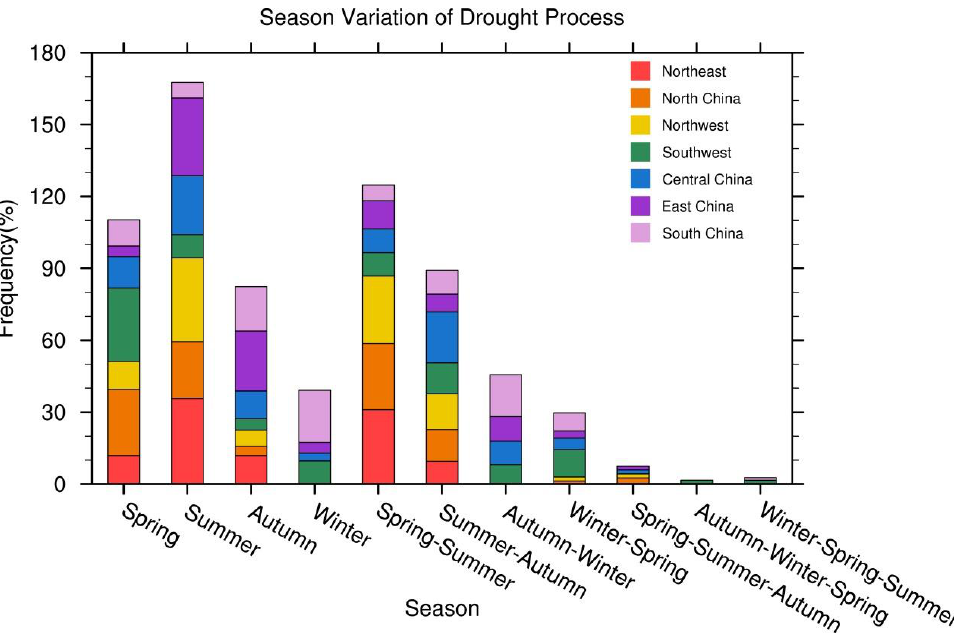
Figure 6. Seasonal distribution of regional drought processes in China from 1961 to 2021. In North China, both spring droughts and a spring-to-summer consecutive drought occurred 21 times, tied first place, and accounted for 27.6% of all seasonal droughts in this region. Summer droughts occurred 18 times and accounted for 23.7% of all seasonal droughts in this region; a summer-to-autumn consecutive drought occurred 10 times and accounted for 13.2% of all seasonal droughts in this region. Autumn droughts occurred 3 times, accounted for 3.9% of all seasonal droughts in this region; a winter-to-spring con- secutive drought occurred once and accounted for 1.3% of all seasonal droughts in this region. A spring-to-summer-to-autumn consecutive drought, the longest drought pro- cess in this region, occurred twice and accounted for 2.6% of all seasonal droughts in this region. In Northwest China, summer droughts occurred 21 times, ranked first, and ac- counted for 35.0% of all seasonal droughts in this region. Secondly, spring-to-summer consecutive droughts occurred 17 times and accounted for 28.3% of all seasonal droughts in this region. Summer-to-autumn consecutive droughts, spring droughts, and autumn droughts, respectively, occurred 9 times, 7 times, and 4 times, and accounted for 28.3%, 15%, 11.7% and 6.7% of all seasonal droughts in this region, respectively. Both spring-to-summer-to-autumn consecutive droughts and winter-to-spring consecutive droughts occurred once, and each accounted for 1.7% of all seasonal droughts in this re- gion. In Central China, summer droughts occurred 15 times, ranked first, accounted for 24.6% of all seasonal droughts in this region. Secondly, summer-to-autumn consecutive droughts occurred 13 times, and accounted for 21.3% of all seasonal droughts in this re- gion. Spring drought and autumn droughts occurred 8 times and 7 times, respectively, and accounted for 13.1% and 11.5% of all seasonal droughts in this region, respectively. Both spring-to-summer and winter-to-spring consecutive droughts occurred 6 times and accounted for 9.8% of all seasonal droughts in this region. Winter-to-spring consecutive droughts, winter droughts and spring-to-summer-to-autumn consecutive droughts oc- curred 3, 2 and 1 times, respectively, and accounted for 4.9%, 3.3% and 1.6% of all sea-